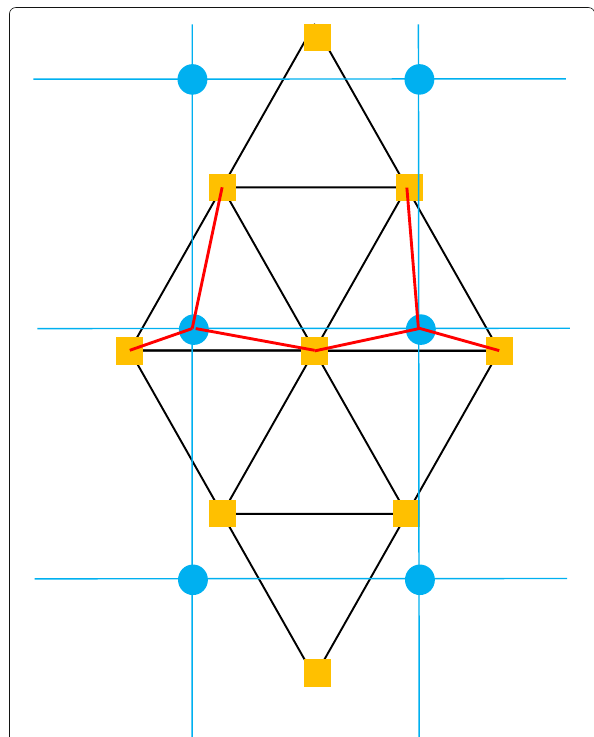
Fig. 10 The interpolation method from NICAM grid to lat-lon grid. Orange squares indicate NICAM grid points and blue circles indicate lat-lon grid points. The lat-lon grid point value is calculated from the values of the vertices of the triangle of the NICAM grid in which the point is included